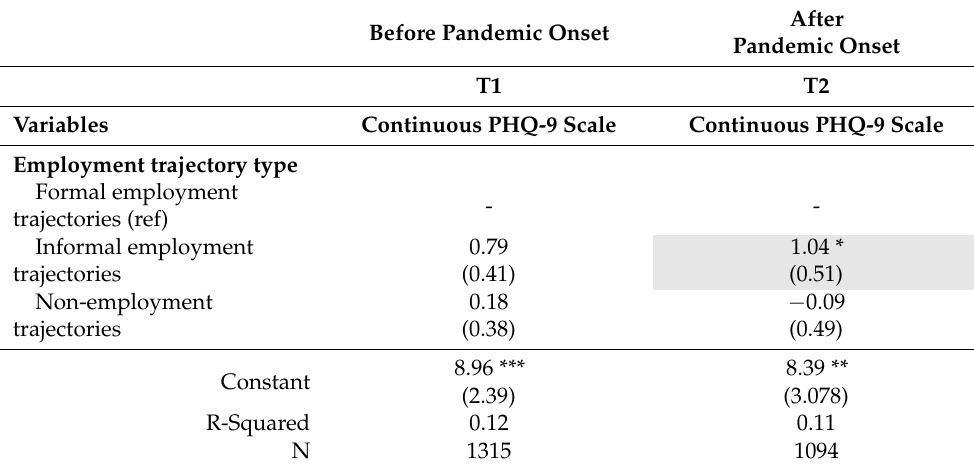
Table A3. Multivariate linear regression models on continuous PHQ-9 scale before and after the onset of the COVID-19 pandemic (collapsed trajectory types).